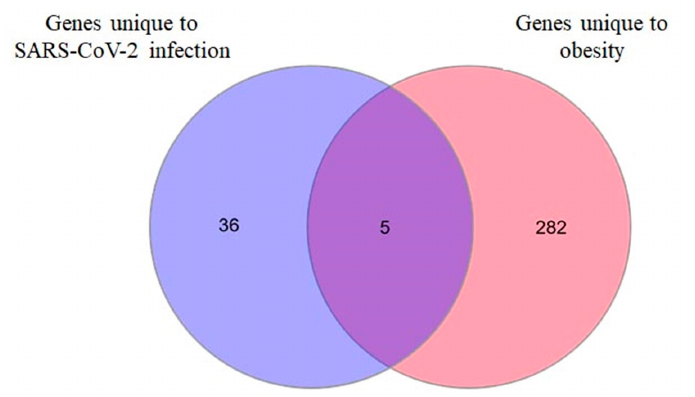
Figure 4. Five DEGs were identified as unique to bronchial epithelial cells from obese subjects and are core players in SARS-CoV-2-infected cells. Venn diagram of intersecting DEGs unique to SARS-CoV-2 infection and associated to obesity. Five genes were identified: CASC5 (KNL1) , LPIN2 , MIR143HG (CARMN) , ULBP1 and THRB .